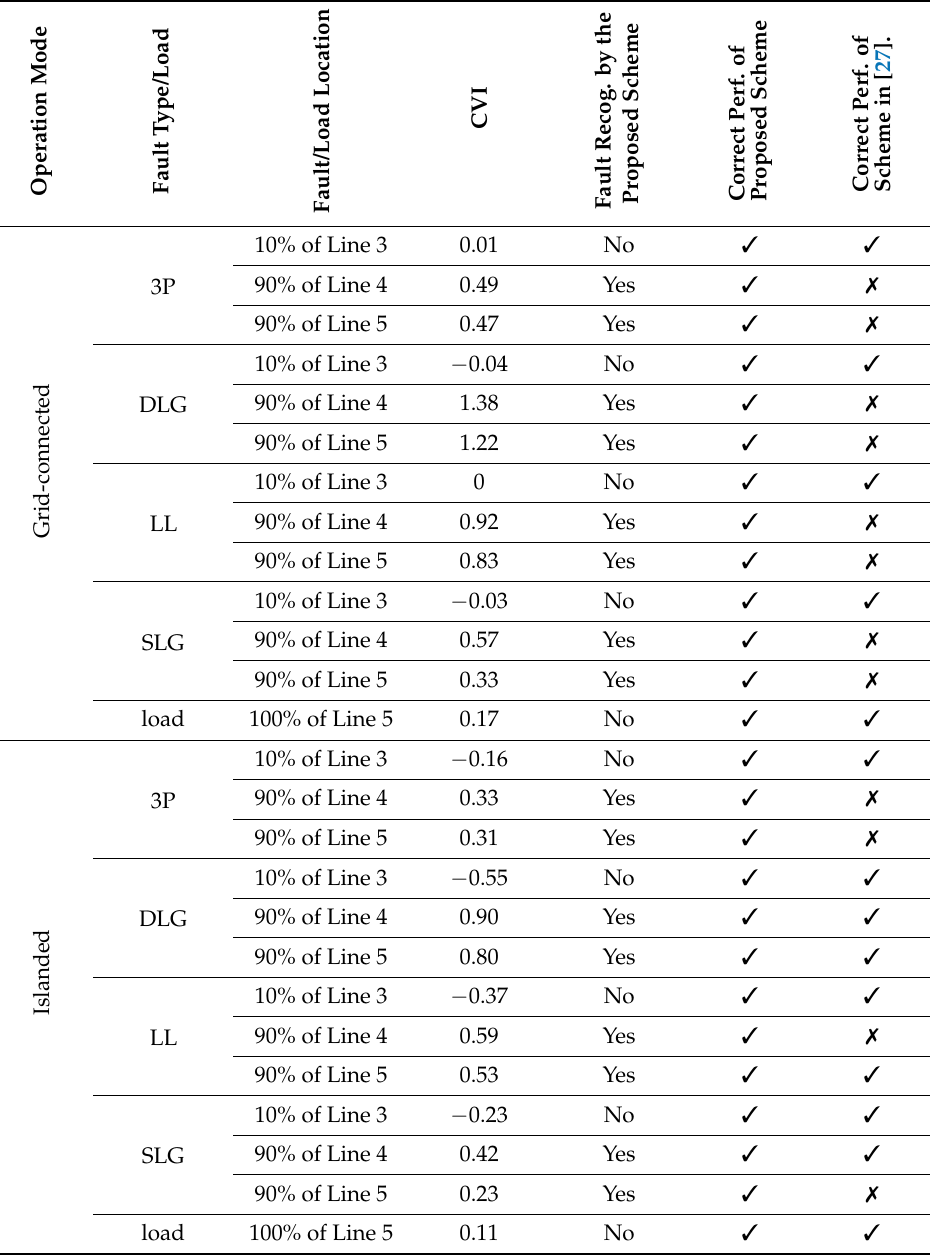
Table 6. Backup protection performance in pre-fault conditions